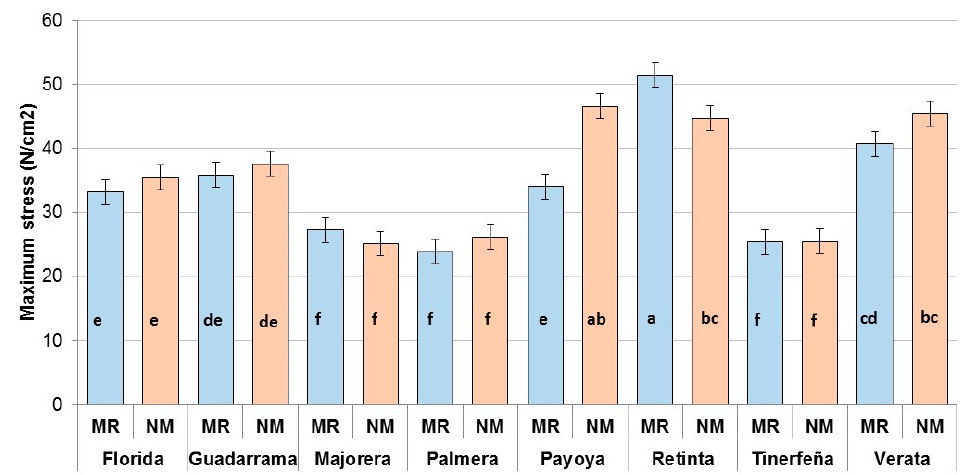
Figure 1. Warner-Bratzler maximum stress of longissimus thoracis muscle from kids reared with milk replacer ( MR ) or natural milk from their dams ( NM ). Different superscripts indicate significant differences ( p < 0.05 ).